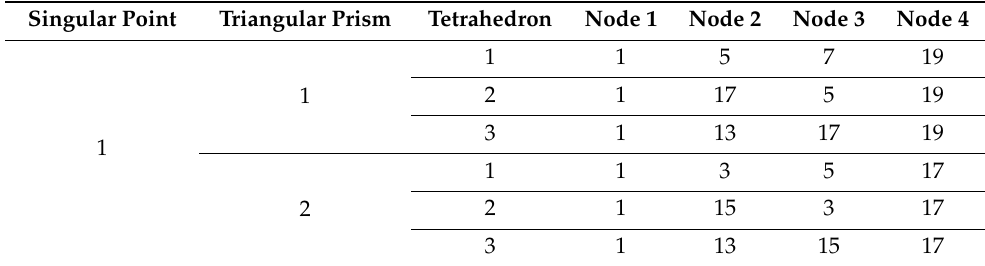
Table 3. A subdivision of each triangular prism into three tetrahedral subcells at each singular point (cid:48) after a subdivision of Ω f into two triangular prisms (see Figure 5b,c). The singular point is located at the corner point of the hexahedral element shown in Figure